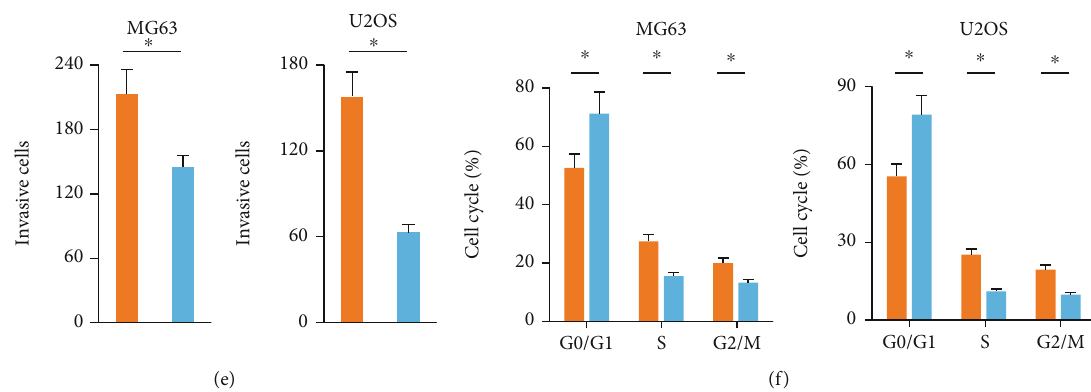
Figure 2: miR-181a-5p inhibitor restrains osteosarcoma progression in vitro. (a) Relative miR-181a-5p level in osteosarcoma cells treated with or without miR-181a-5p inhibitor ( n = 6 ). (b) Cell viability of osteosarcoma cells determined by CCK-8 assay ( n = 6 ). (c) Colony numbers in osteosarcoma cells with or without miR-181a-5p inhibitor treatment ( n = 6 ). (d) Gap size in the wound healing experiments ( n = 5 ). (e) Invasive cells in transwell experiments with or without miR-181a-5p inhibitor treatment ( n = 6 ). (f) Cell cycle distribution in di ff erent phases ( n = 5 ). All data are presented as the mean ± SD , ∗ P < 0 : 05 versus the matched